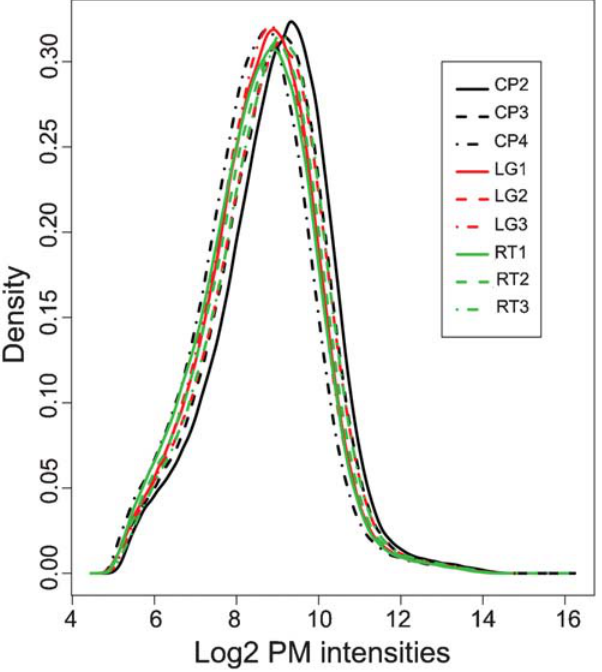
Figure 1. Density plots for the raw PM probes intensity data. The data are in log2 scale and the biological replicate arrays for rice varieties CP, LG and RT are shown in black, red and green color respectively. CP=Cypress, LG=LaGrue, RT=RT0034 and PM=perfect